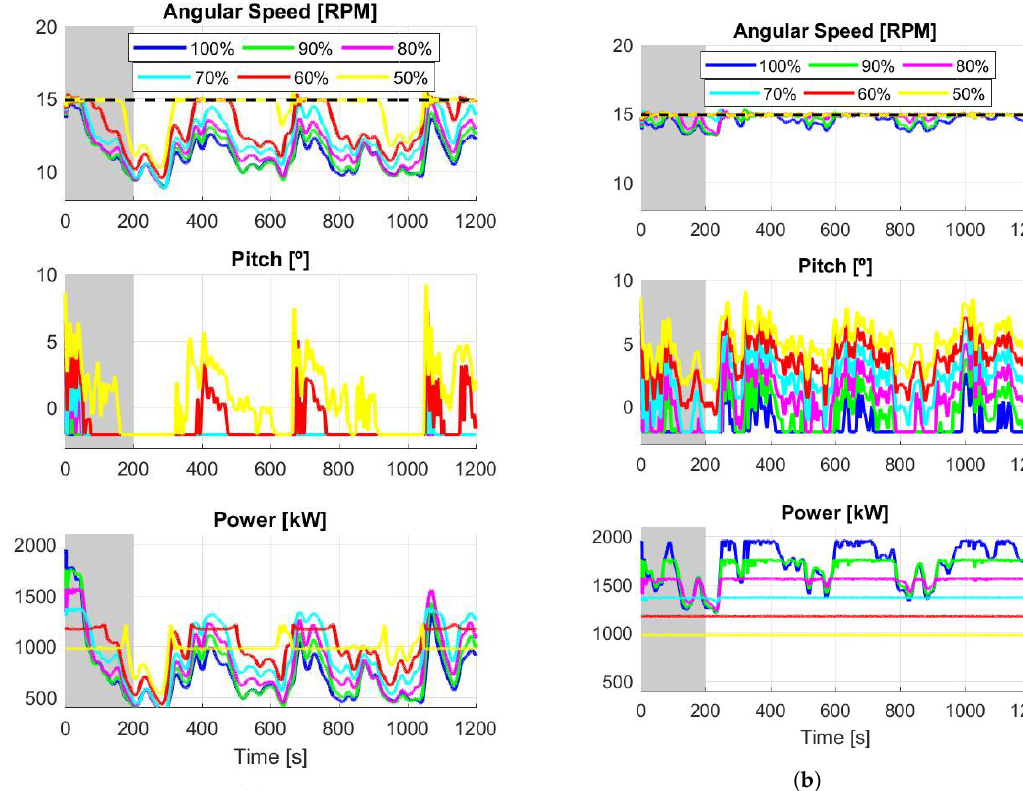
Figure 9. ( a ) WT3 and ( b ) WT4 de-rated operation. Inflow condition of the simulation: Wind direction 147 ◦ (wake interaction between wind turbines) and wind speed below rated. Six constant de-rated signals applied on each wind